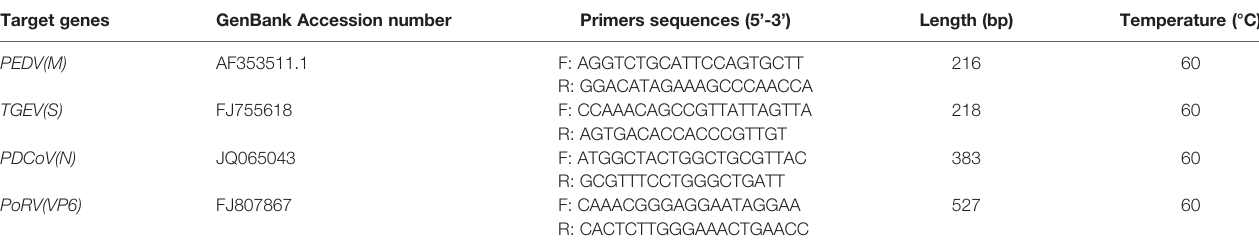
TABLE 1 | Primers and sequence information for pathogen identi fi